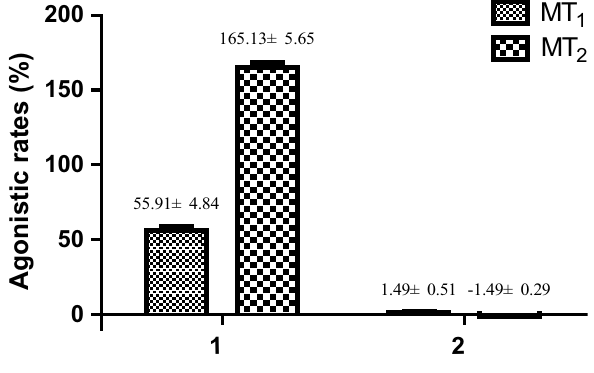
Fig. 3 MT 1 and MT 2 receptors agonistic activities of compounds 1 and 2 (0.5 mM). Data are expressed as mean ± S.D., n=3. Melatonin was used as the positive control with EC 50 values of 1.0 nM (MT 1 ) and 25.0 nM (MT 2